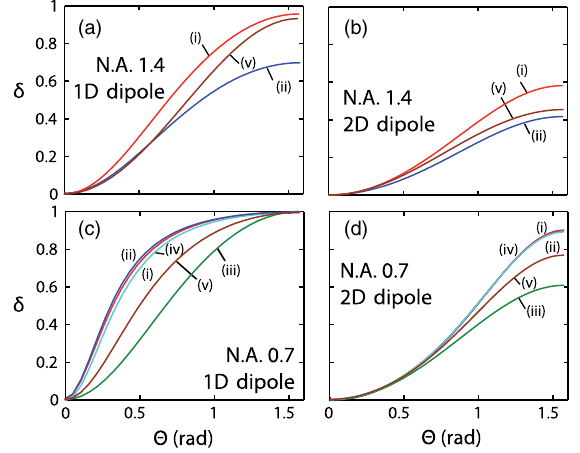
FIG. 5. Theoretical value of δ as a function of the angle Θ for a 1D dipole (a,c) or a 2D dipole (b,d) with numerical aperture 1.4 (a,b) or 0.7 (c,d), calculated in situations (i), (ii), and (v) for (a,b) and situations (i) – (v) for (c,d), with d ¼ 50 nm for cases (ii) and (iv) and d ¼ 0 for cases (iii) and (v), and λ ¼ 620